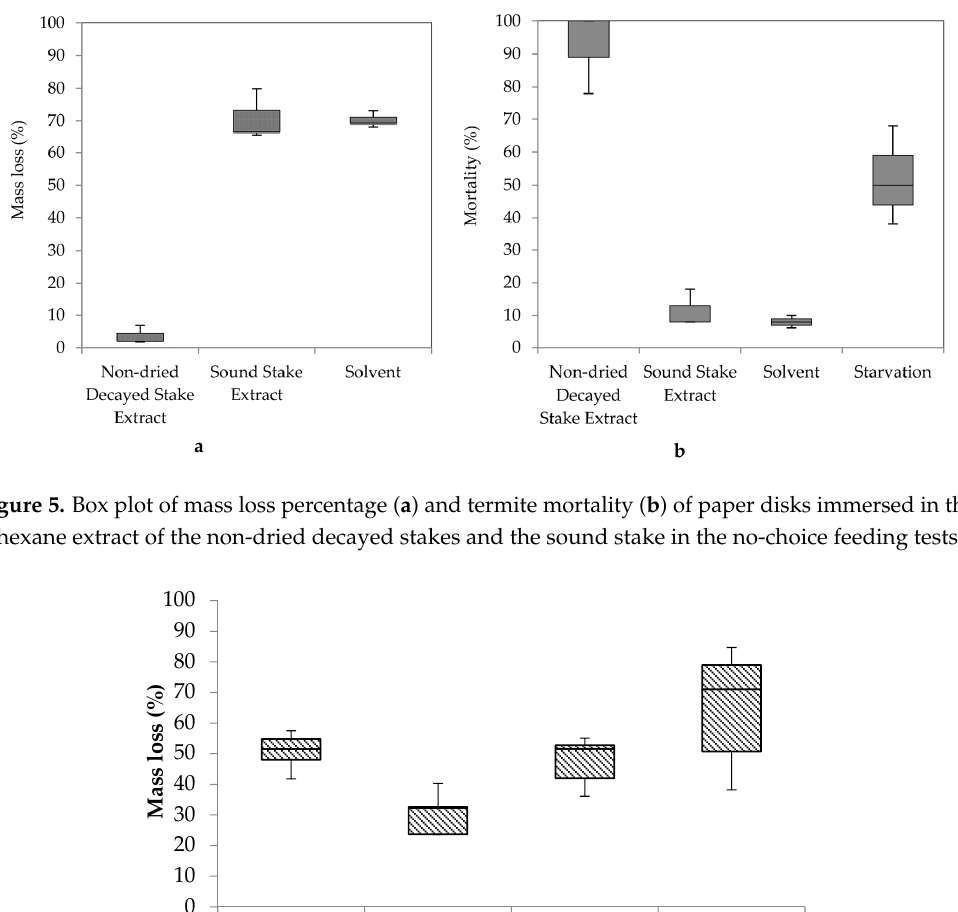
Figure 5. Box plot of mass loss percentage ( a ) and termite mortality ( b ) of paper disks immersed in tests.